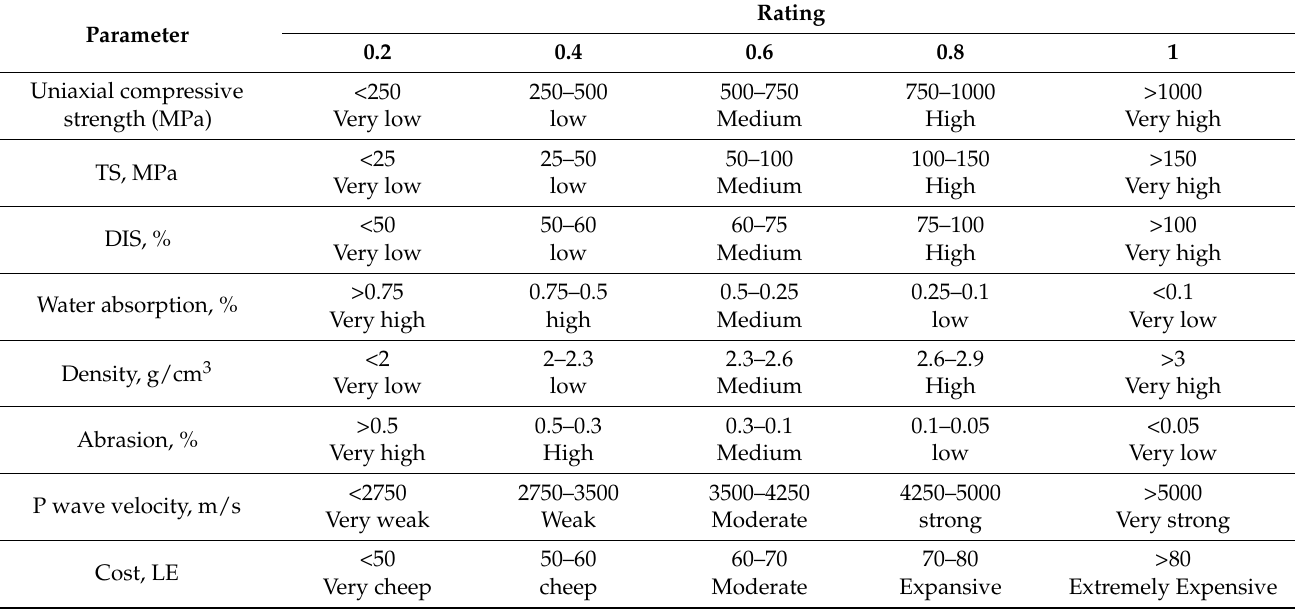
Table 4. Ratings assigned to different parameters